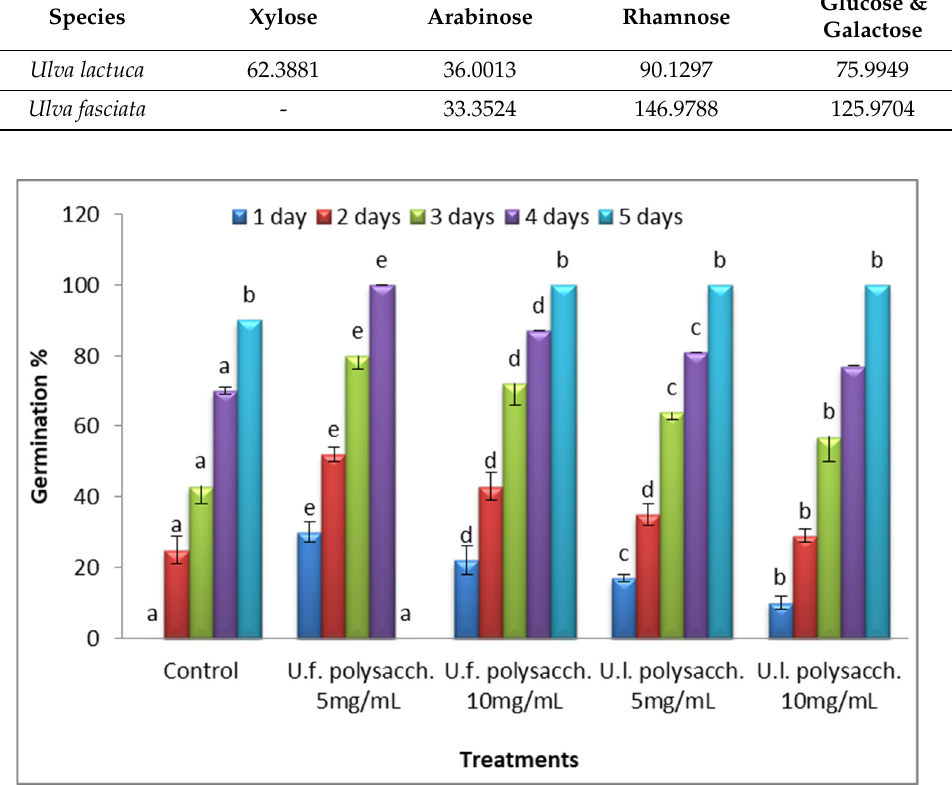
Figure 2. Effect of seed priming with different concentrations of soluble polysaccharides on the percentage of seed germination recorded daily during the germination period of Zea mays . The bars represent the standard error (different letters denote the significant value among the treatments on the same day ( p value= 0.0000). U.f., Ulva fasciata; U.l. , Ulva lactuca.